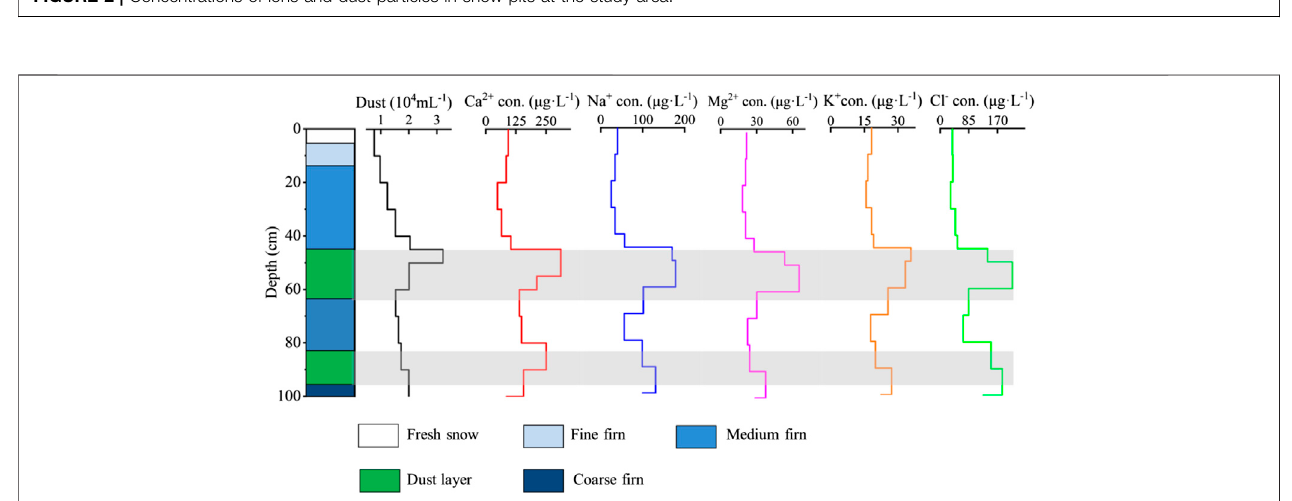
FIGURE 2 | Concentrations of ions and dust particles in snow pits at the study area.